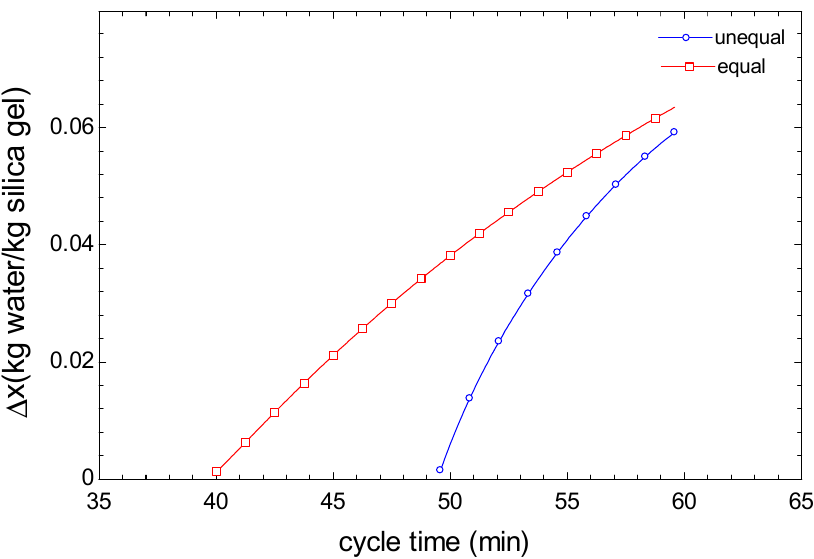
Figure 5. Adsorption/desorption exchange rates variance.